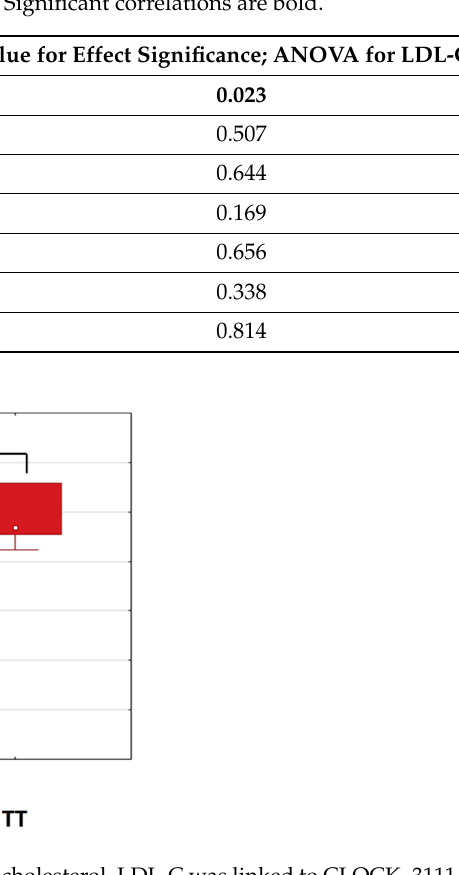
Figure 5. Evening rise in low-density lipid cholesterol, LDL-C was linked to CLOCK_3111 (rs1801260) TT genotype. Kruskal–Wallis, KW-H (1;18) = 5.500; p = 0.019. N = 18.; TC = 12; TT = 6 *: p <